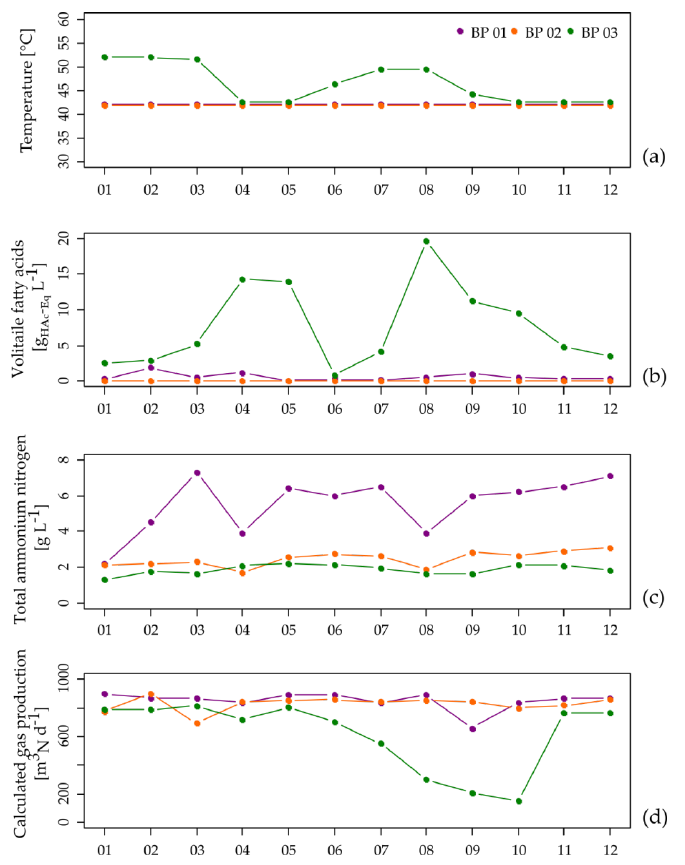
Figure 1. Process temperature ( a ), concentration of total volatile fatty acids ( b ) and total ammonium nitrogen ( c ) at the points of sampling of the analyzed main anaerobic digesters as well as the calculated biogas amounts of the entire biogas plants ( d ) over a time period of one year. Samples of the main digester content were taken monthly over one year according to Theuerl et al. [65], considering that the samples were characteristic for the digester content at the respective